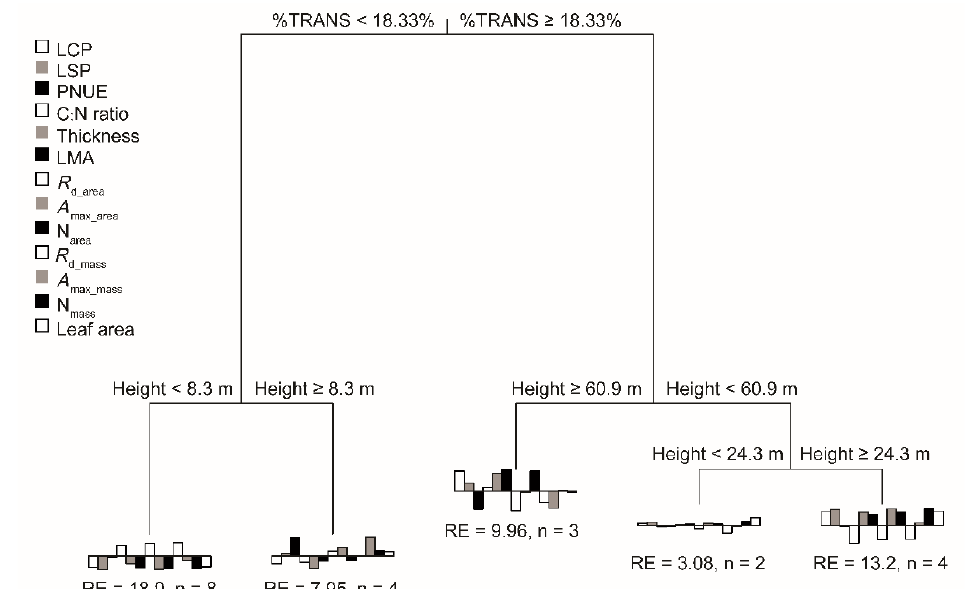
Figure 5. Multivariate regression tree for the leaf traits data. All data include explanatory variables (height and ln(%TRANS)), and response variables (leaf traits) were standardized in MRT analysis, but the explanatory variables were restored to raw values in this figure for clarity. Bar plots show the multivariate traits’ mean at each node. The cyclical shadings (white, gray, and black) indicate the various traits and run from left to right across the bar plots.